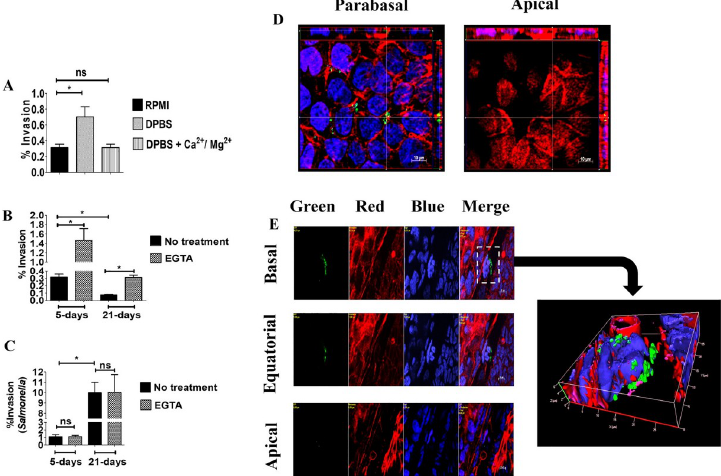
Fig 3. Enhanced GBS invasion of Caco-2 cells after disruption of intercellular junctions. Five-day-old islets and 21-day-old monolayers of Caco-2 cells were infected with GBS and extracellular bacteria were killed with antibiotics. Prior to infection, cells were treated as indicated to disrupt intercellular junctions. ( A ) Effects of Ca 2+ and Mg 2+ on GBS invasion of 5-day-old islets, as measured by CFU counts in cell lysates. DPBS, Dulbecco’s PBS without Ca 2+ and Mg 2+ . ( B ) Effect of EGTA on GBS invasion, as measured by CFU counts in cell lysates. ( C ) Effect of EGTA treatment of Caco-2 cells on S . enterica var. Typhymurium (strain M20) invasion, as measured by CFU counts in cell lysates. Values shown in A , B and C are means ± SD of three independent experiments conducted in triplicate. � , p < 0.05 by Mann-Whitney test. ( D ) Evidence of numerous invading streptococci (Green) in the parabasal region of a 5-day-old islet treated with EGTA. Orthogonal views from x/z and y/z planes are depicted laterally to show the tridimensional location of bacteria. ( E ) Bacteria interacting with the basal region of 21-day-old monolayers after EGTA treatment. Yellow labels indicate the filter(s) used and the distance, in μ m, of the optical section from the slide plane. On the right is a three-dimensional reconstruction centered in the area indicated by the dashed rectangle. Bacteria (Green) were stained with an anti-GBS rabbit serum, followed by Alexa Fluor 488-conjugated anti-rabbit IgG. Actin (Red) and nuclei (Blue) were stained with Phalloidin-iFluor 555 and DAPI, respectively. Scale bar = 10 μ m. https://doi.org/10.1371/journal.pone.0253242.g003 required for GBS invasion, Caco-2 cells were treated with cytochalasin B and nocodazole, which specifically inhibit actin filaments and microtubules, respectively. Treatment with cythocalasin B and, to a lesser extent, with nocodazole significantly decreased invasion of BM110 GBS, compared to control cells ( Fig 5A ). Moreover, immunofluorescence microscopy indicated that at 30 minutes post-infection GBS strongly interact with actin filaments, as indi- cated by colocalization between bacteria and phalloidin-stained actin at cell entry sites ( Fig 5B ).